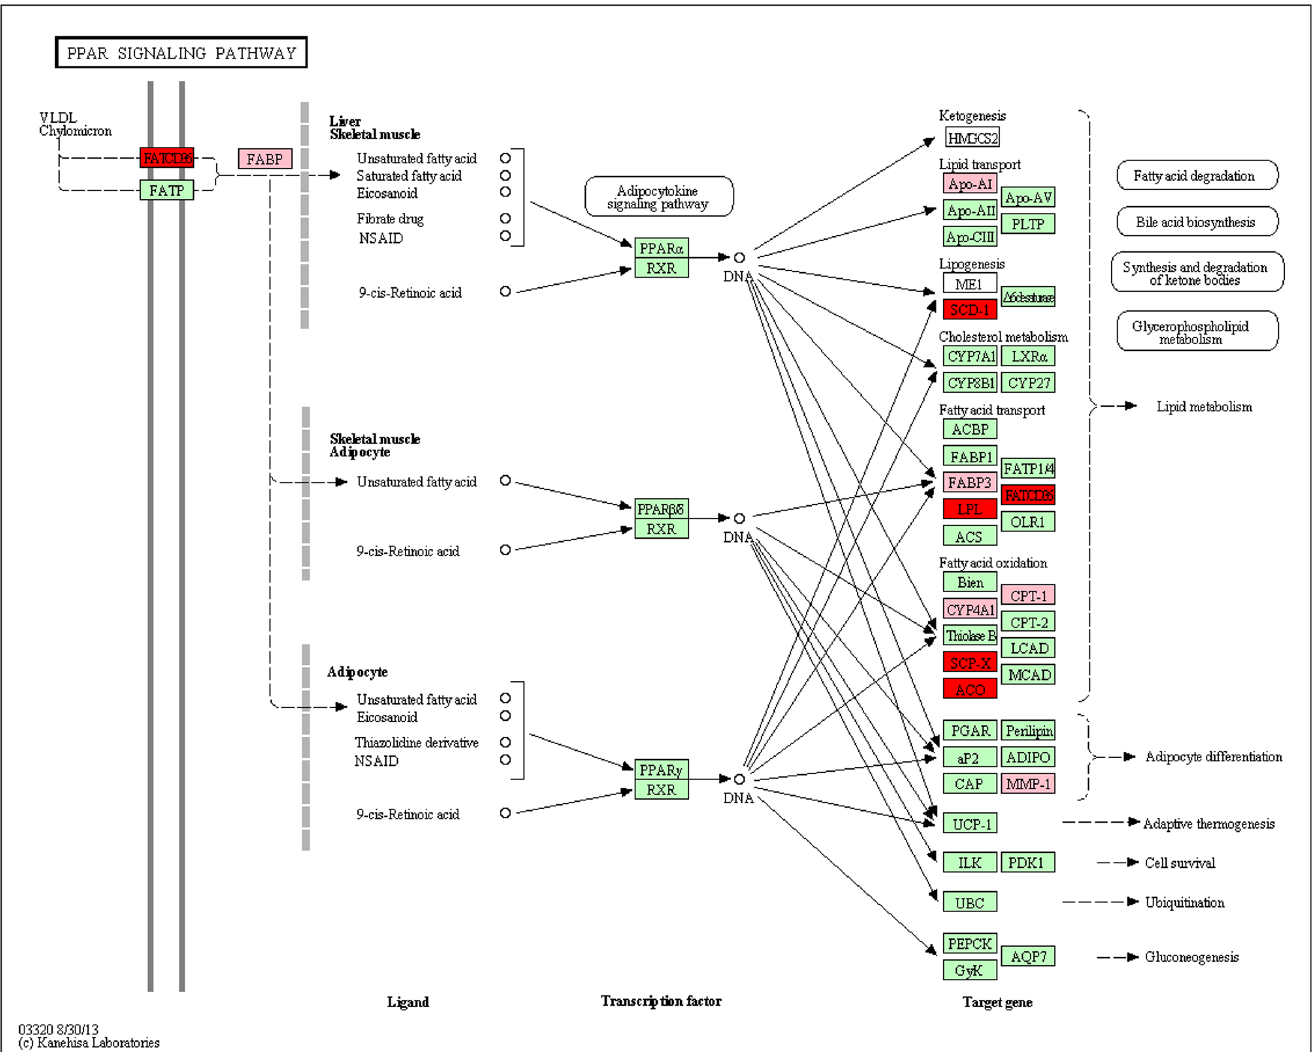
Fig 3. The significantly enriched genes in the ‘ PPAR signaling pathway ’ . Red nodes indicate the significantly up-regulated genes in fat-1 transgenic cattle, and the pink nodes indicate the significantly down-regulation